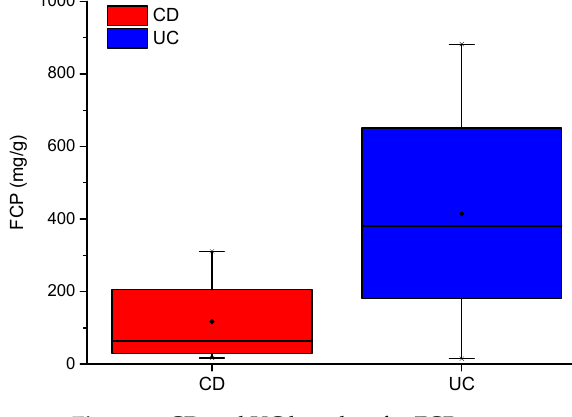
Figure 1. CD and UC boxplots for FCP scores. Table 1. Demographic data of IBD patients and healthy